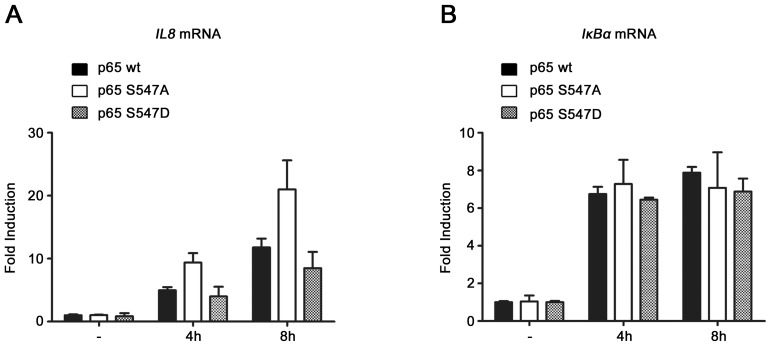
Similar etoposide-induced gene expression profile in cells expressing wt and S547D mutated p65.qRT PCR analysis of IL8 (A), and IκBα (B) mRNA level after 4 and 8 hours of etoposide treatment in HEK-293 cells expressing either p65wt, p65S547A, or p65S547D.